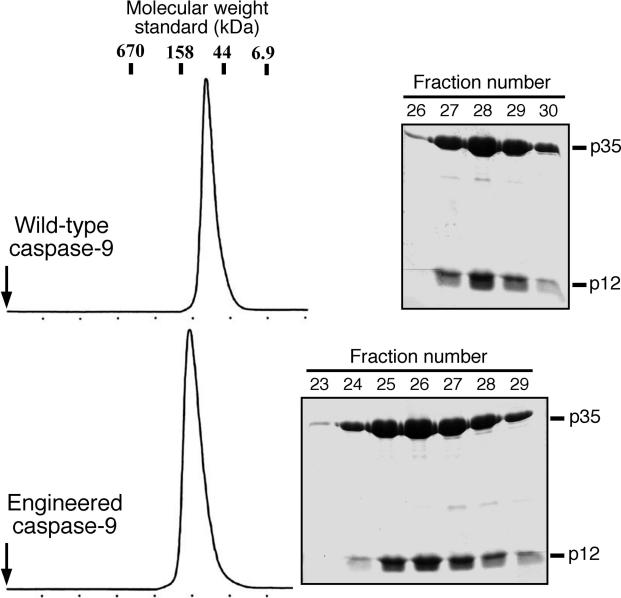
The Dimeric Caspase-9 Exists as a Monomer in SolutionThe apparent molecular masses for the WT and dimeric caspase-9 (full-length, residues 1–416) were analyzed by gel filtration. Relevant peak fractions were visualized by SDS-PAGE followed by Coomassie staining. The dimeric caspase-9 was eluted from the column with a molecular mass about twice that of the WT protein.